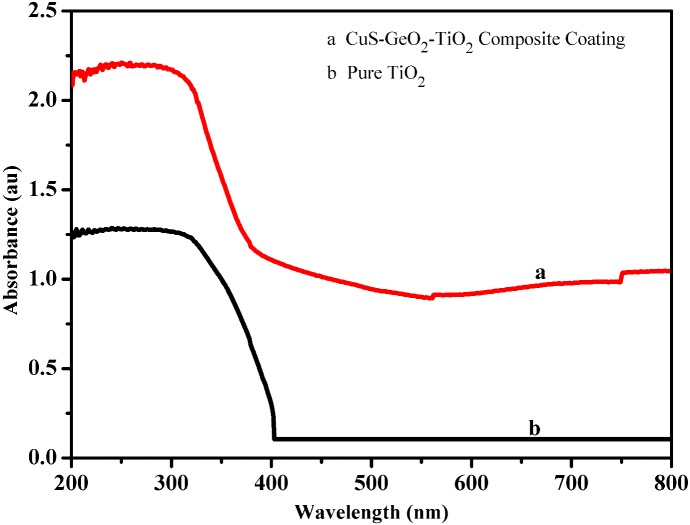
UV-Vis DRS of CuS-GeO2-TiO2 composite coating (a) and pure TiO2 (b).